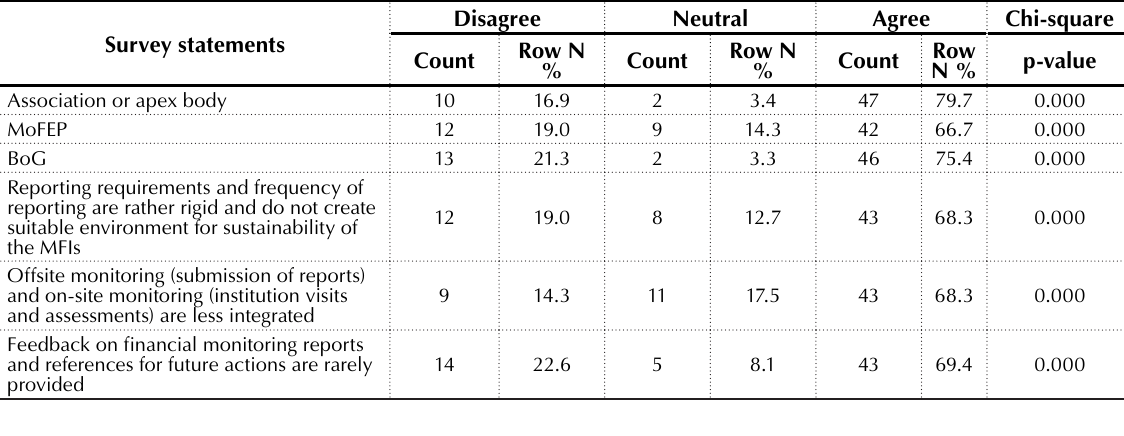
Table 6. Implementation